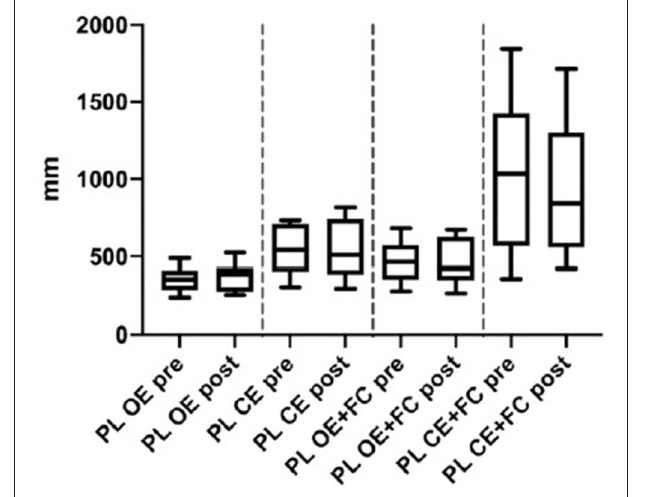
FIGURE 1 | Posturography: Path length of Menièr’s patients before (pre) and 24 h- after (post) the intratympanic injection. OE, Open Eyes; CS, Closed Eyes; PC, Foam cushion under feet. Data we presented as boxes and whiskers (Tukey method).